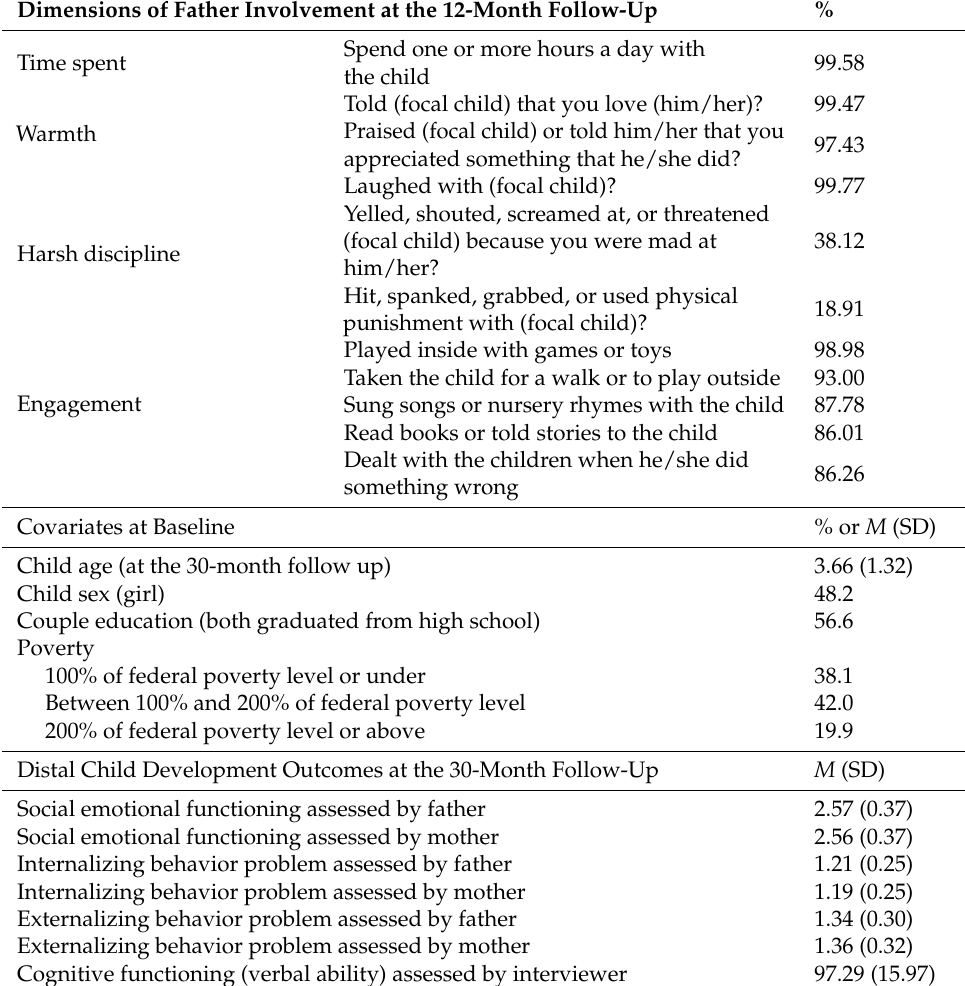
Table 2. Descriptive statistics for the indicators, covariates, and distal outcomes ( N = 2650). Dimensions of Father Involvement at the 12-Month